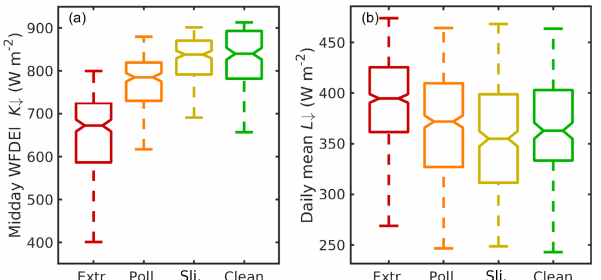
Figure 7. Box plots of (a) midday WFDEI incoming solar radiation ( K ↓ WF ) and (b) modelled daily mean incoming longwave radiation ( L ↓ ) stratified by different pollution level (extremely polluted air, polluted air, slightly polluted, and fairly clean air) for 2001–2013. See “Statistical methods” for